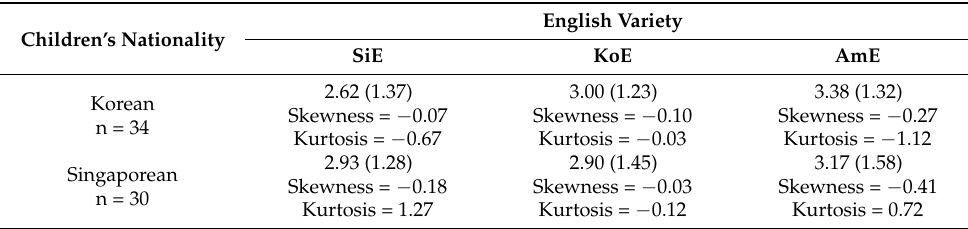
Table 3. Mean score (SD) of children’s ratings for the Singaporean, Korean, and American English